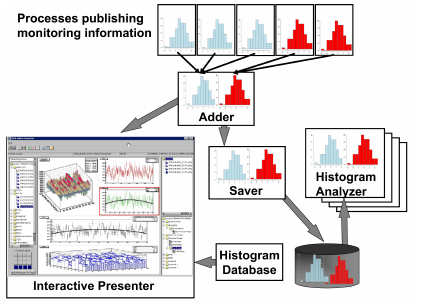
Figure 1. DIM communication scheme [1]. Figure 2. Scheme of DIM collecting, merging and publishing histograms